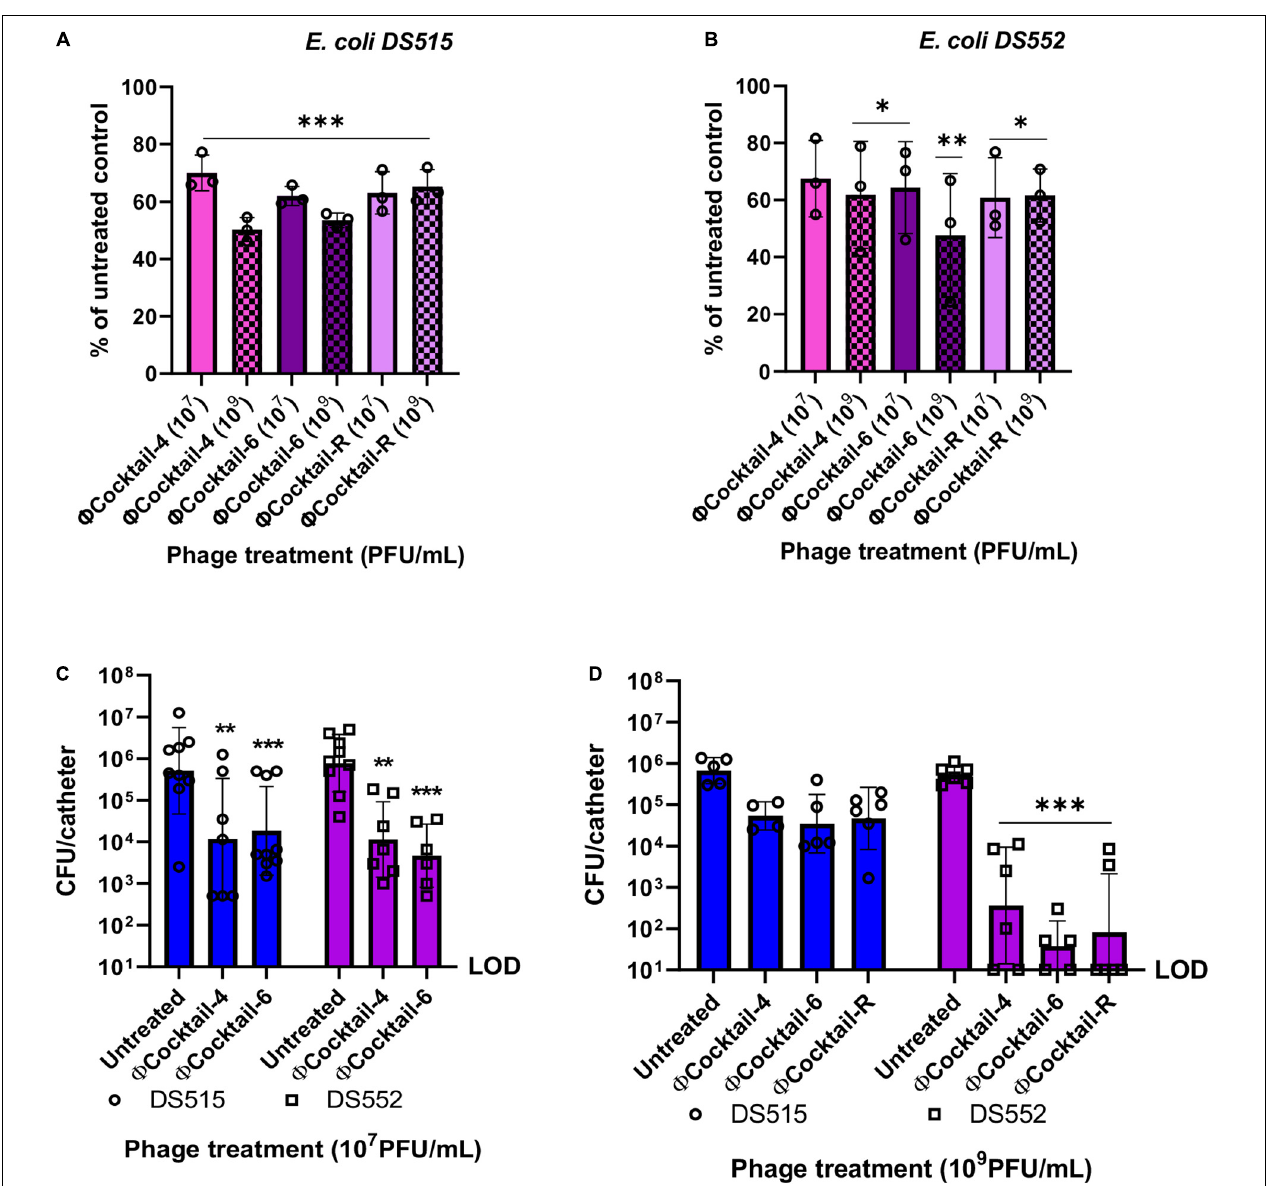
FIGURE 7 | Activity of phage cocktails against 7-day biofilms and biofilms on catheter material in human urine. Biofilms of E. coli DS515 (A) and DS552 (B) were grown in human urine for seven consecutive days and then treated with two doses of phage cocktails for 24 h. Results depict the percentage of viable biofilms after treatment with phage, using the untreated control biofilm as the denominator (A,B) . Silicon RenaSil tubing pieces ( ∼ 6 mm) were incubated in bacterial suspensions in human urine for 48 h, washed and treated with 10 7 PFU/mL of phage cocktails for 4 h (C) or 10 9 PFU/mL of phage cocktails for 6 h (D) . Silicon tubing was washed, sonicated, and the resulting fluid was plated to quantify the bacterial burden. (cid:56) Cocktail-4: HP3, ES17, ES21, and ES26, (cid:56) Cocktail-6: HP3, ES12, ES17, ES19, ES21, and ES26, and (cid:56) Cocktail-R: HP3, ES17, ES19, and HP3.1. ∗ p < 0.05, ∗∗ p < 0.01, ∗∗∗ p < 0.001. CFU, colony forming units; LOD, limit of